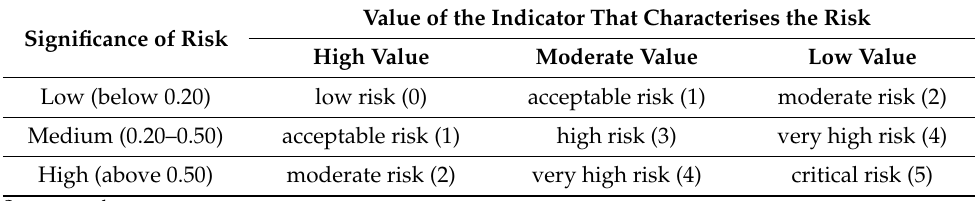
moderate risk (2) very high risk (4) critical risk